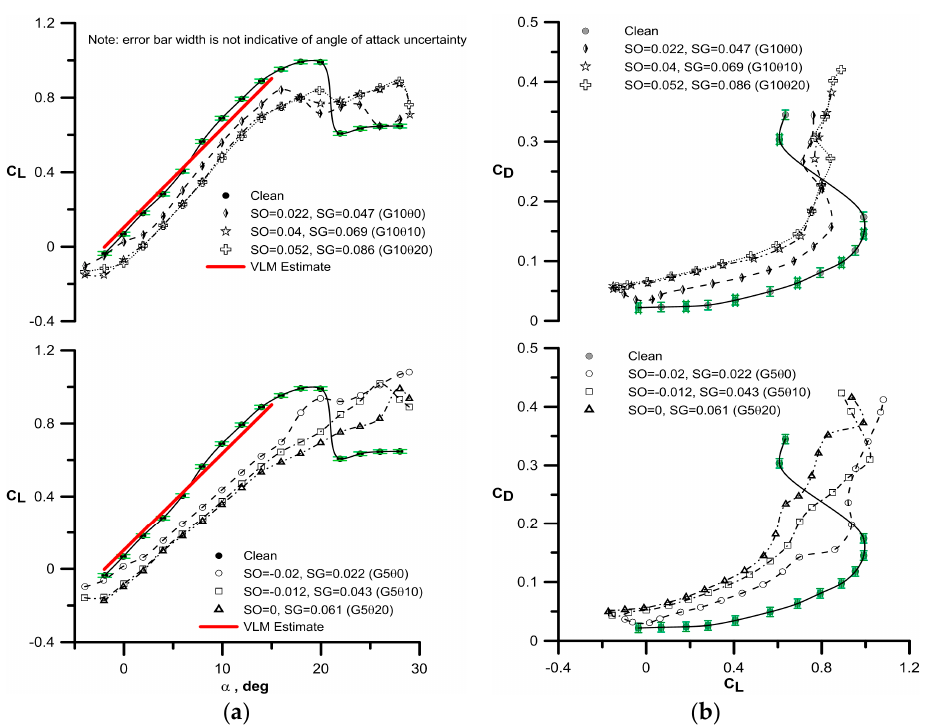
Figure 2. Effect of slat gap and angle on the ( a ) measured lift coefficient and ( b ) drag coefficient, error bars are shown in green.